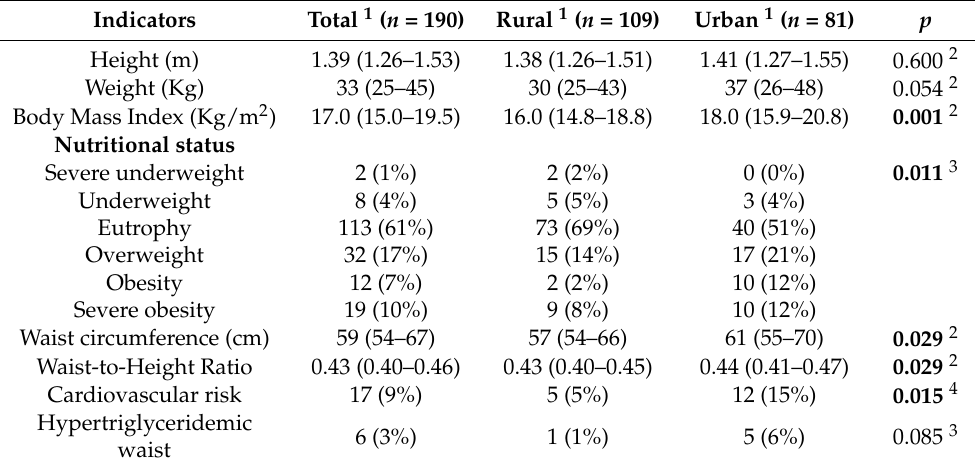
Table 3. Anthropometric characteristics of the participants according to school